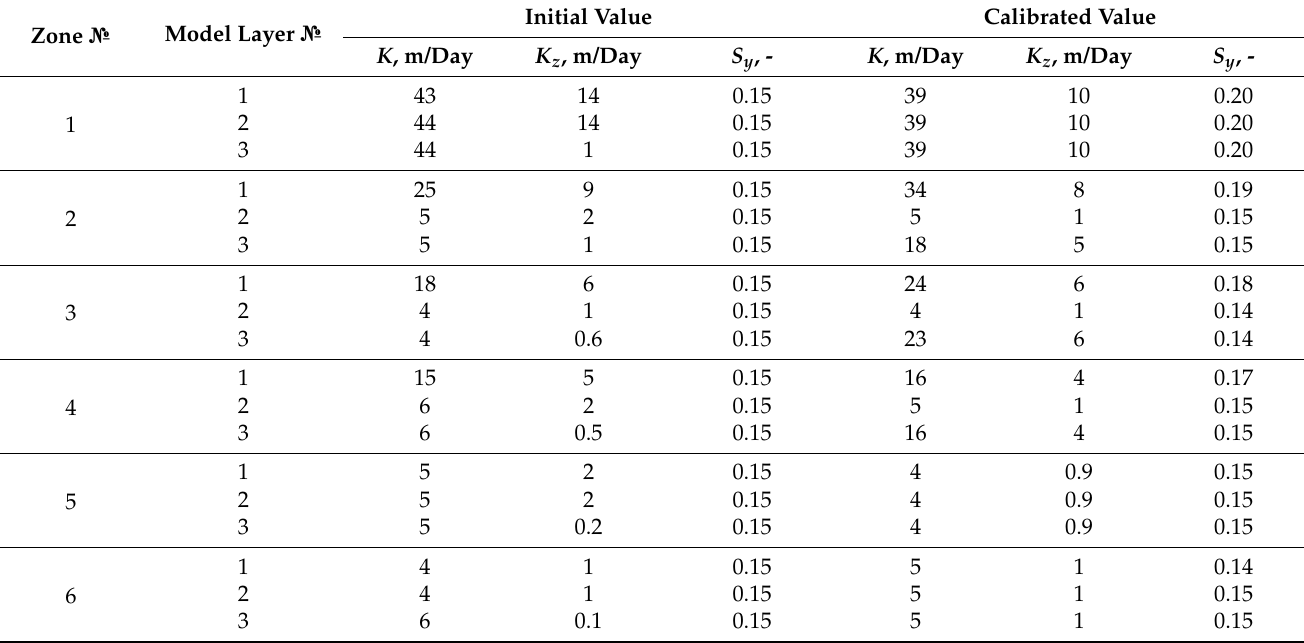
Table 2. Initial and calibrated values of the hydraulic parameters for the Ejina water balance model (The parameter zones are presented in Figure